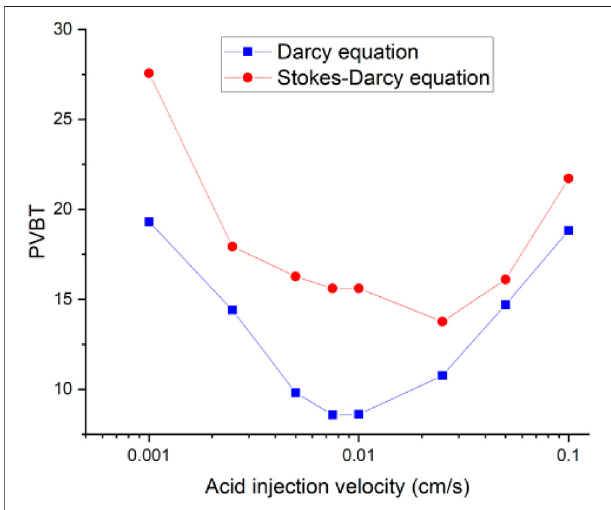
FIGURE 3 | Isolated fracture acidizing curves of pore volume to